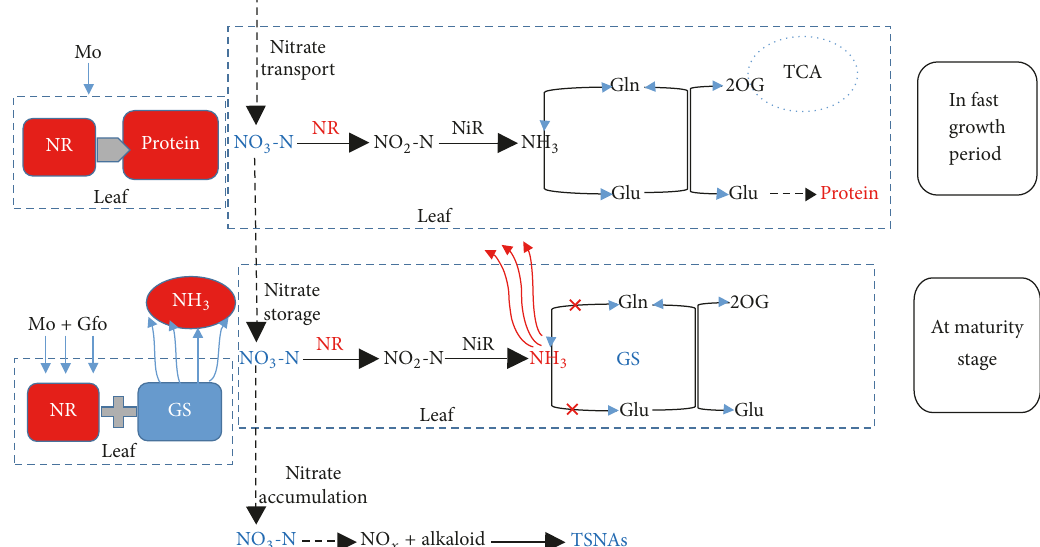
Figure 8: Mechanisms for decreasing nitrate and TSNA concentrations in tobacco by spraying regulating chemicals. Gfo: glufosinate, NR: nitrate reductase, NRA: nitrate reductase activity, NiR: nitrite reductase, GS: glutamine synthetase, GSA: glutamine synthetase activity, Gln: glutamine, Glu: glutamate, and OG: oxaloacetate. After spraying Mo on tobacco during the fast-growth period, nitrate significantly decreased while NRA and soluble protein content increased. These decreased the amount of nitrate storage and promoted tobacco development during the fast-growth period. After spraying Mo during the fast-growth stage and spraying Mo and Gfo at the stage of maturity, NRA increased and GSA decreased in tobacco, which can significantly reduce nitrate accumulation and TSNA formation by nitrogen loss due to ammonia